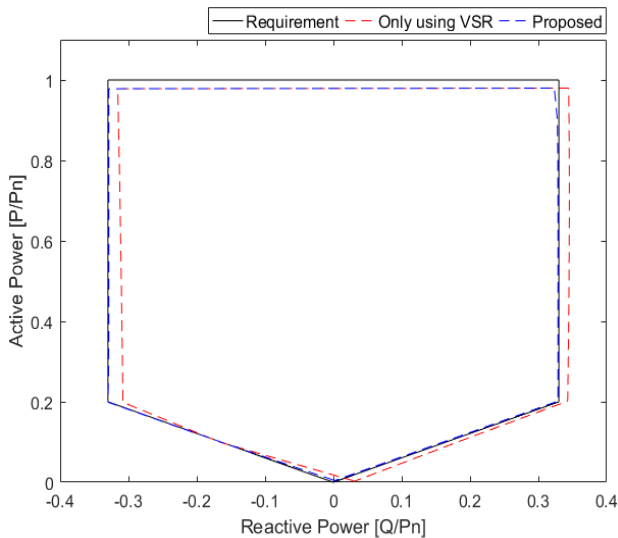
Figure 12. Reactive power capability by reactive power control method.